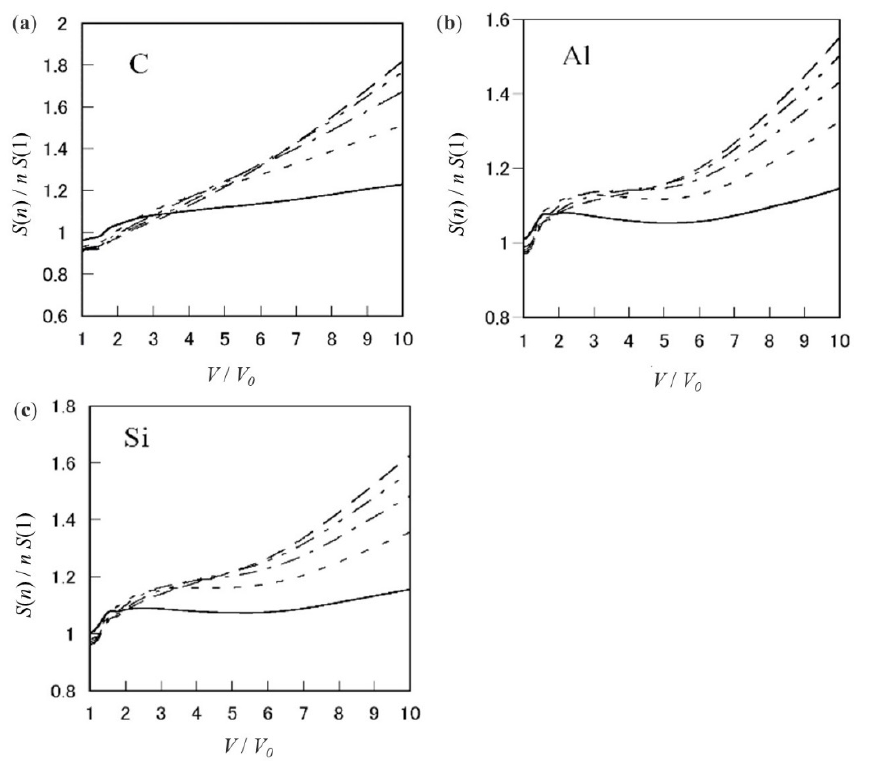
Figure 12. Ratio of electronic stopping power of ( a ) carbon, ( b ) aluminum, and ( c ) silicon for a C n ( 2,3,4,6,10 n = ) cluster as a function of speed [21].